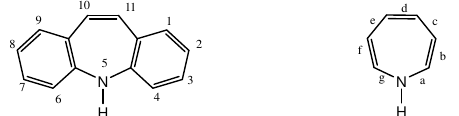
Figure 1. Numbering of the ring position of 5H-dibenz[ b,f